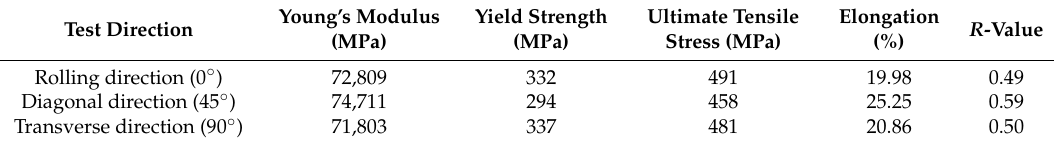
Table 3. Material properties MP2 of tested material: UNS